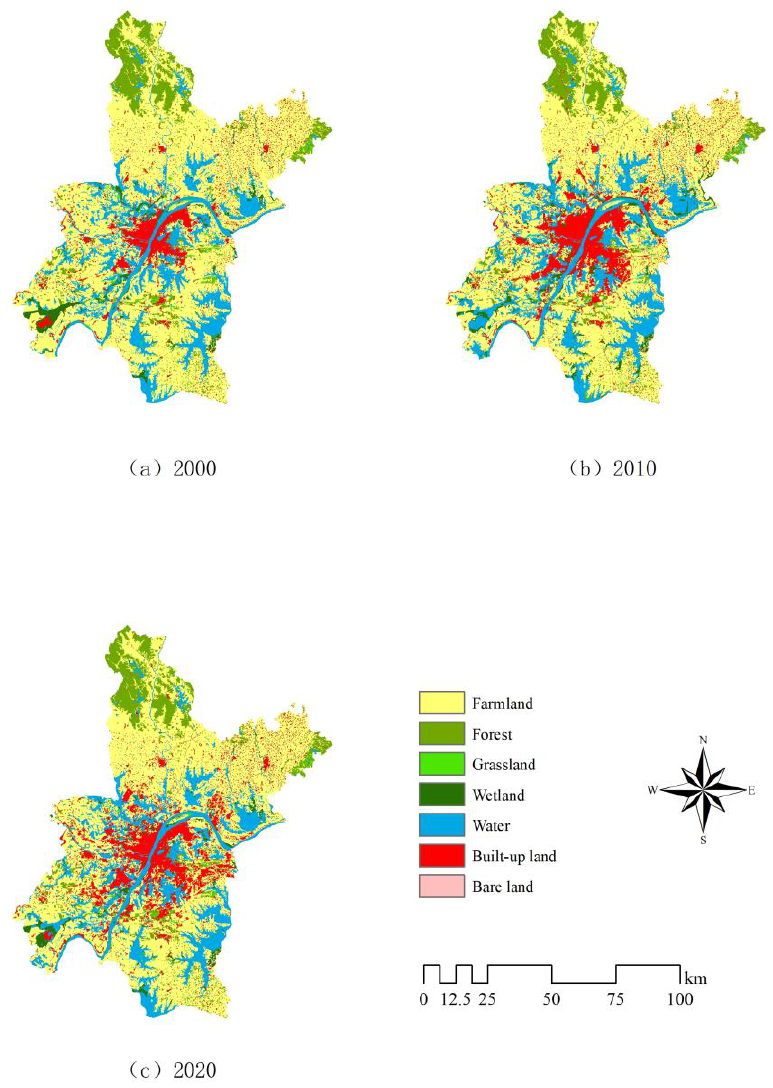
Figure 2. Land use distribution in Wuhan.